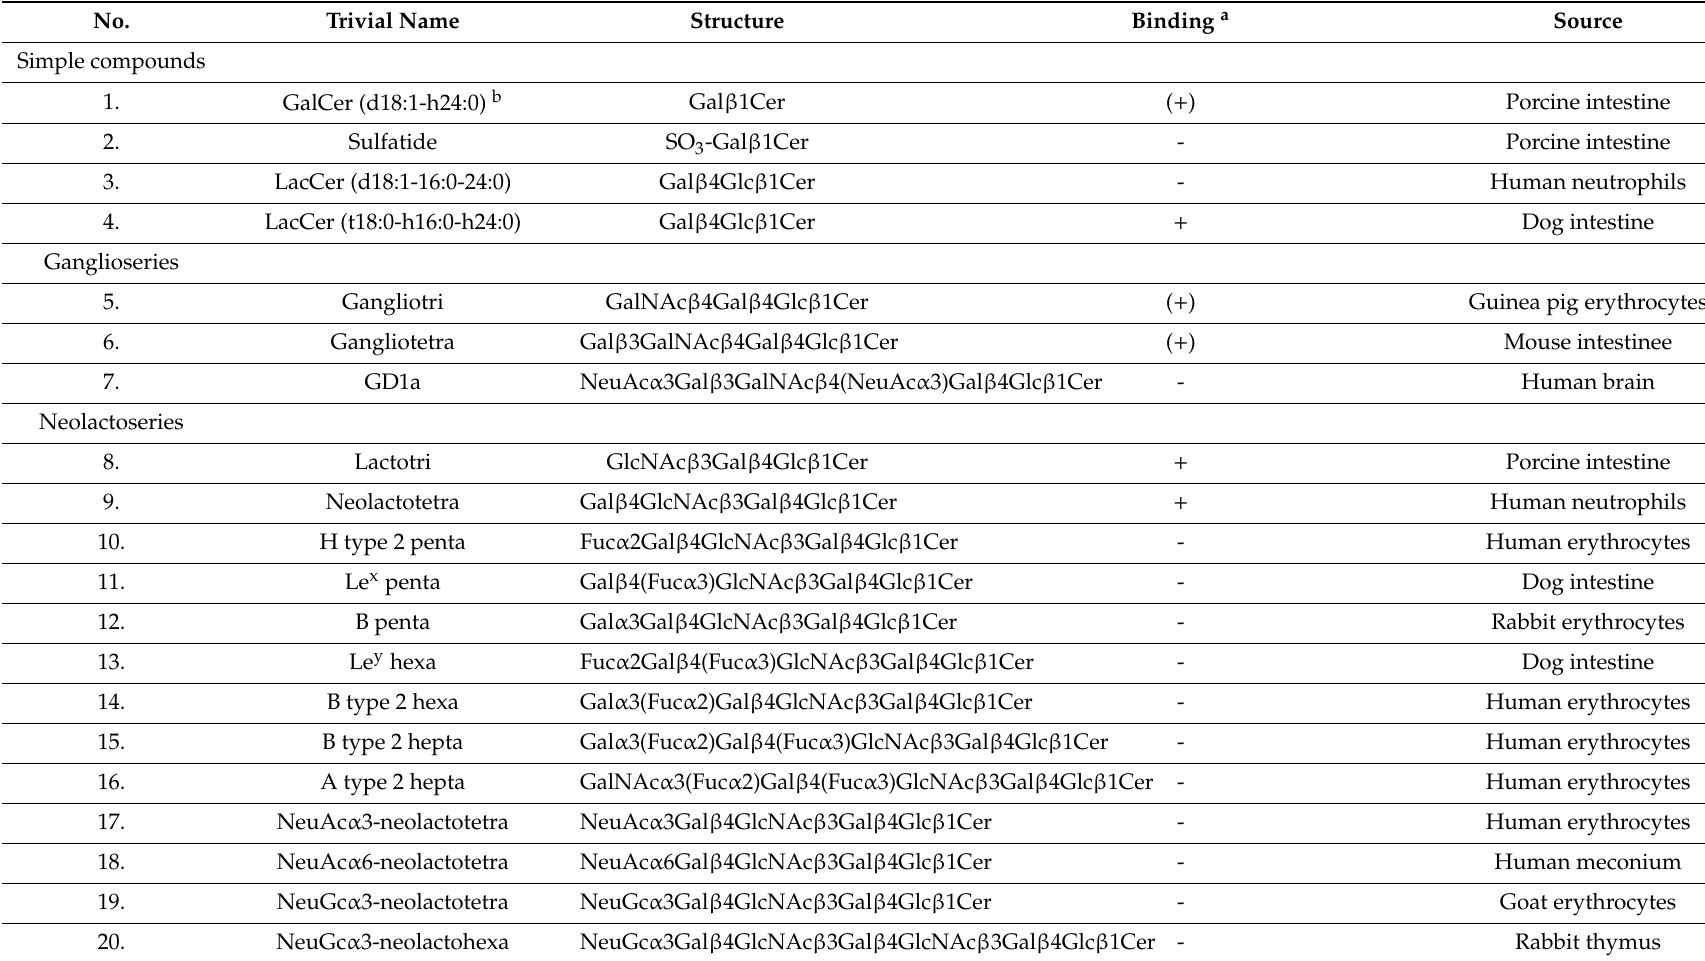
Table 1. Binding of Acinetobacter baumannii to reference glycosphingolipids on thin-layer chromatograms.